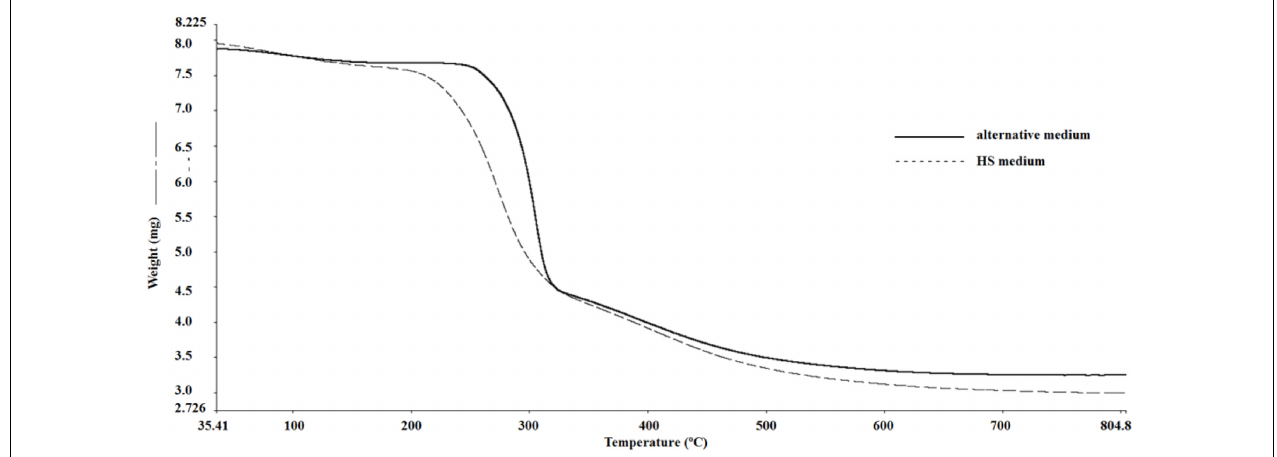
FIGURE 3 | TG curves of BC pellicles obtained after 10 days of fermentation in Hestrin–Schramm (HS) medium (2% glucose, 0.5% yeast extract, 0.5% peptone, 0.27% Na 2 HPO 4 , and 1.5% citric acid) and obtained in the alternative medium formulated with 1.5% glucose, 2.5% CSL, 0.27% Na 2 HPO 4 , and 1.5% citric acid.